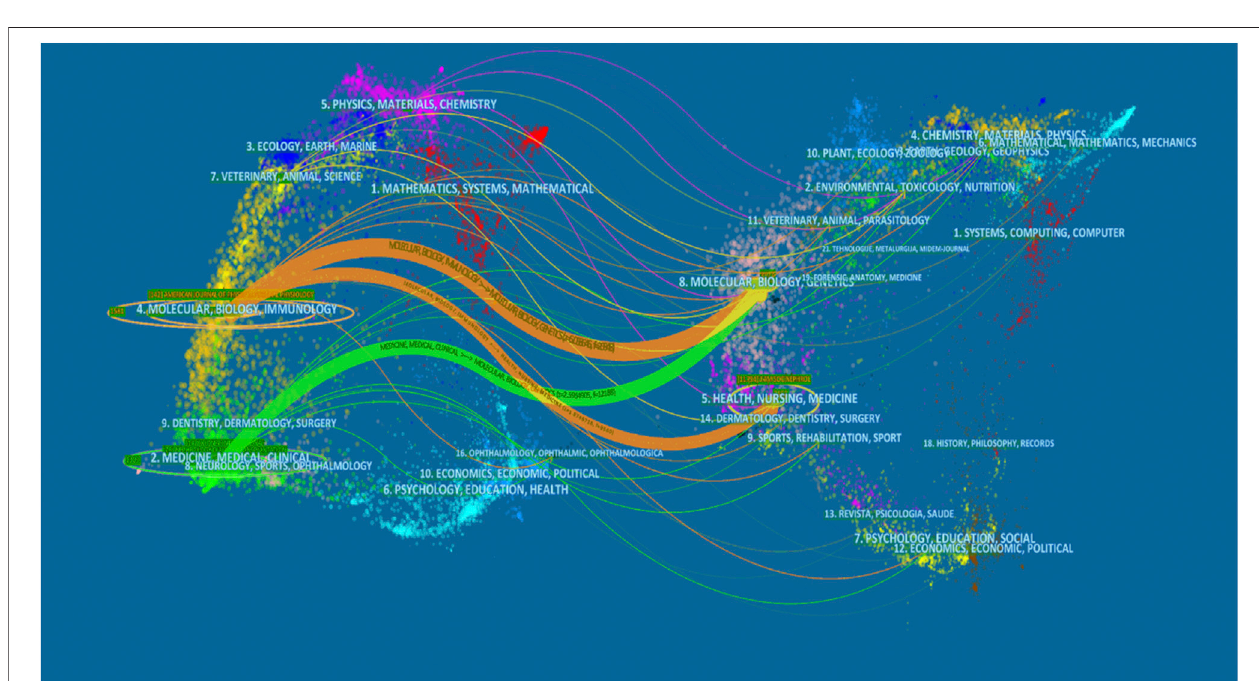
FIGURE4| Thedual-mapoverlayofarticlescitingonpodocyteinjuryresearch.(Theleftsidewerethecitingjournal,therightsidewerethecitedjournal,andtheline path represents the citation relationship).